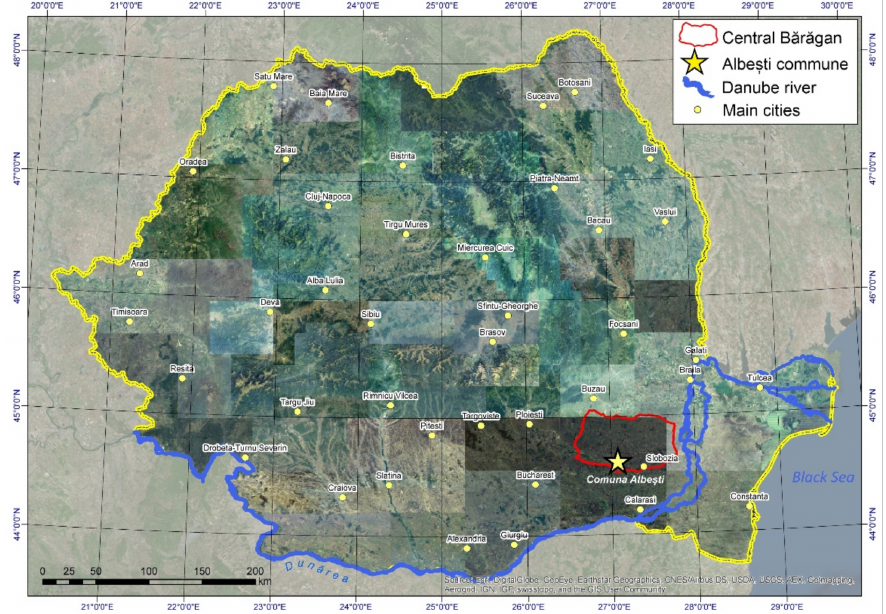
Figure 1. Central B ă r ă gan Plain—geographic location within Romania. Basemap provided by National Agency for Cadastre and Land Registration